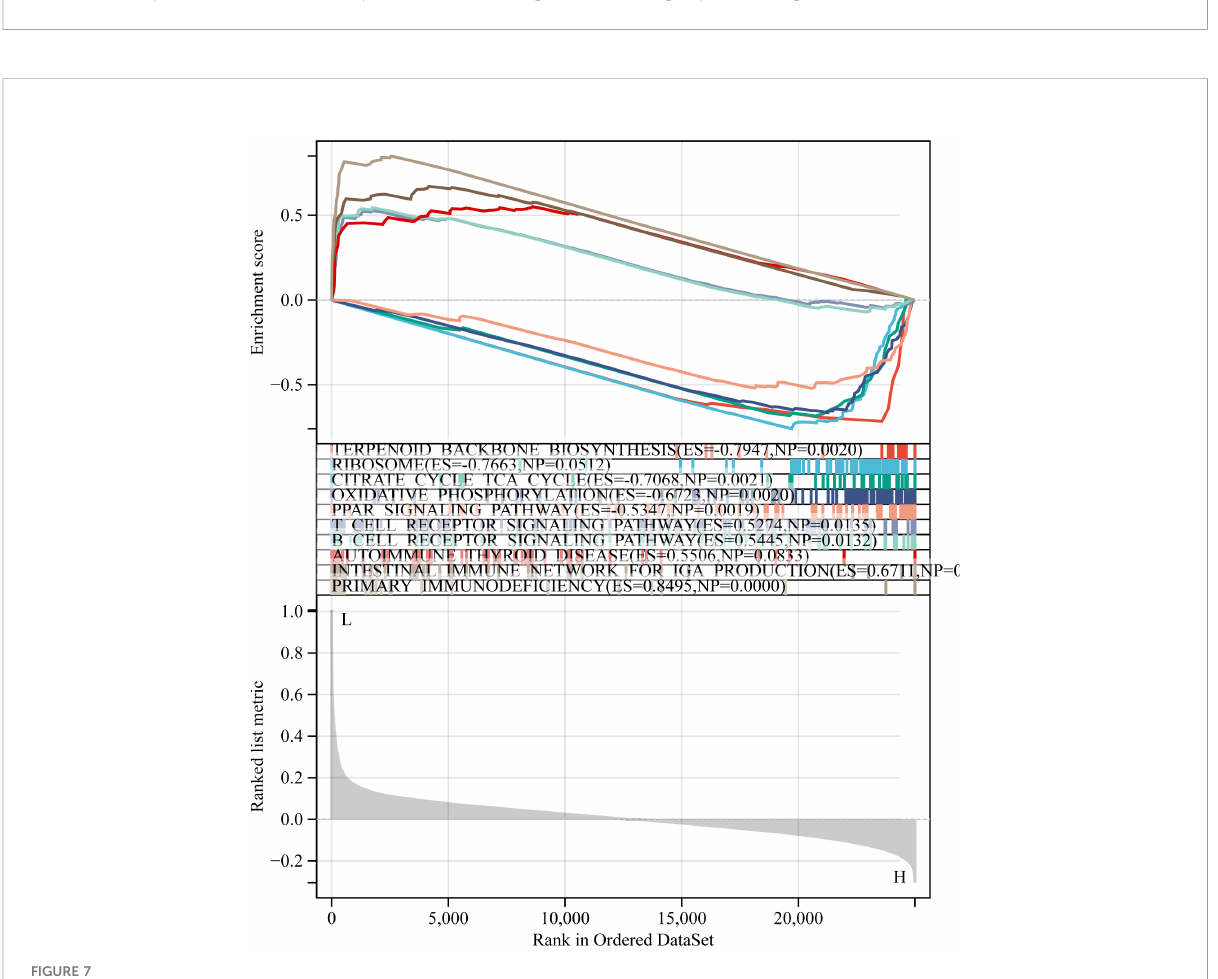
FIGURE 7 Gene set enrichment analysis is presented. P<0.05; False discovery rate